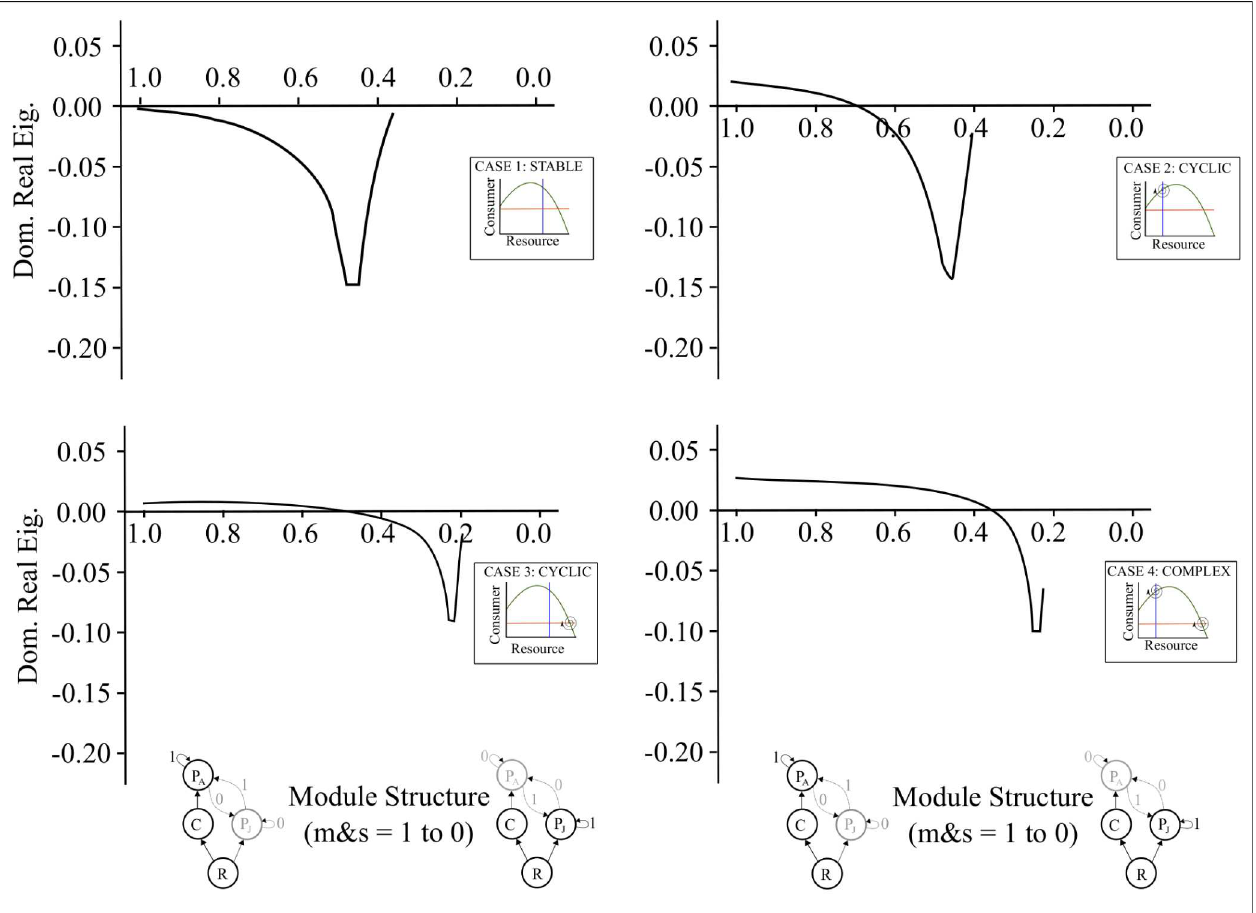
Fig 3. Eigenvalue stability in the LHIGP module. Patterns of stability for Cases 1–4 (a-d) starting from a food chain module and moving towards an exploitative competitionmoduleas m & s decreasefrom 1 to 0 (Parameter values: r = 1.5, K = 1, a CR = 3, a PC = 1, a PR = 0.2, b CR = 1.5, b PC = 1, b PR = 1 , d C = 0.3 (b and d), 0.5 (a and c), d P = 0.1 (c and d), 0.15(a and